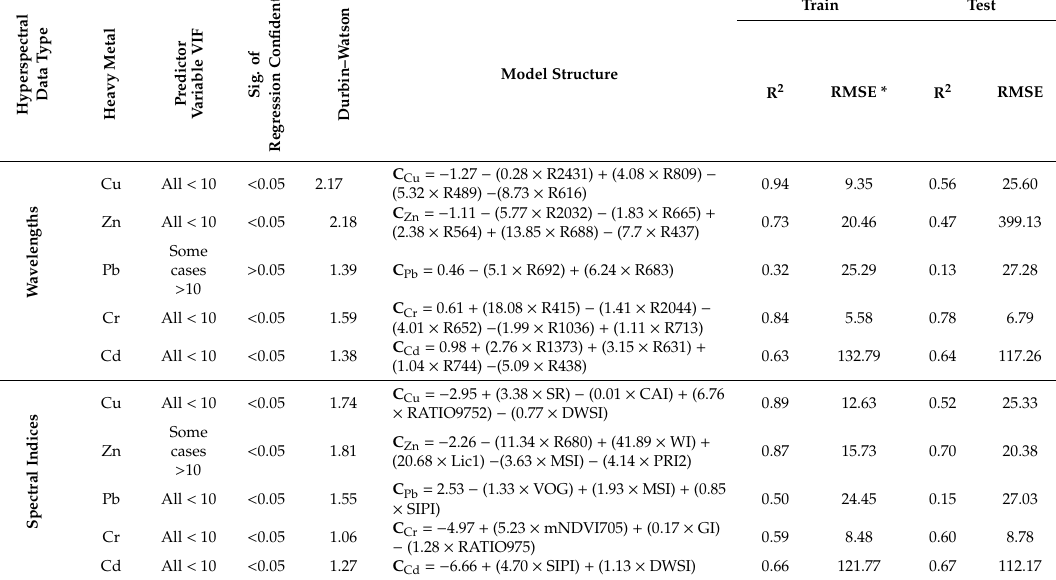
Table 4. The results of modelling and validation of the best multiple linear regression (MLR) models based on optimal wavelengths and spectral indices for estimating heavy metals concentrations in grapevine leaves in training and testing